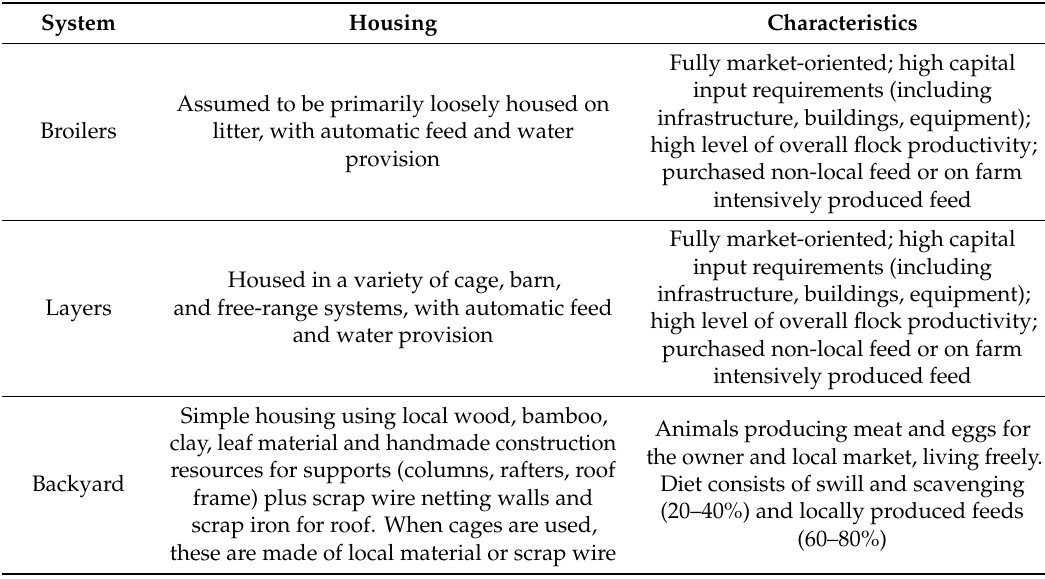
Figure 5. Poultry egg and meat production by husbandry type and geographic region (EASA: East Asia and Southeast Asia; LACA: Latin America and Caribbean; NENA: Near East and North Africa). Data summarized from FAOSTAT Statistical Database [46]. Table 1. Summary of poultry production systems [93].